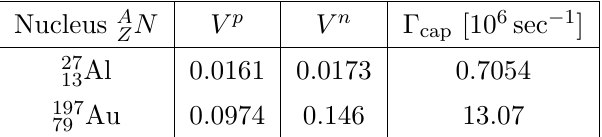
Al and 197 Au nu- 13 79